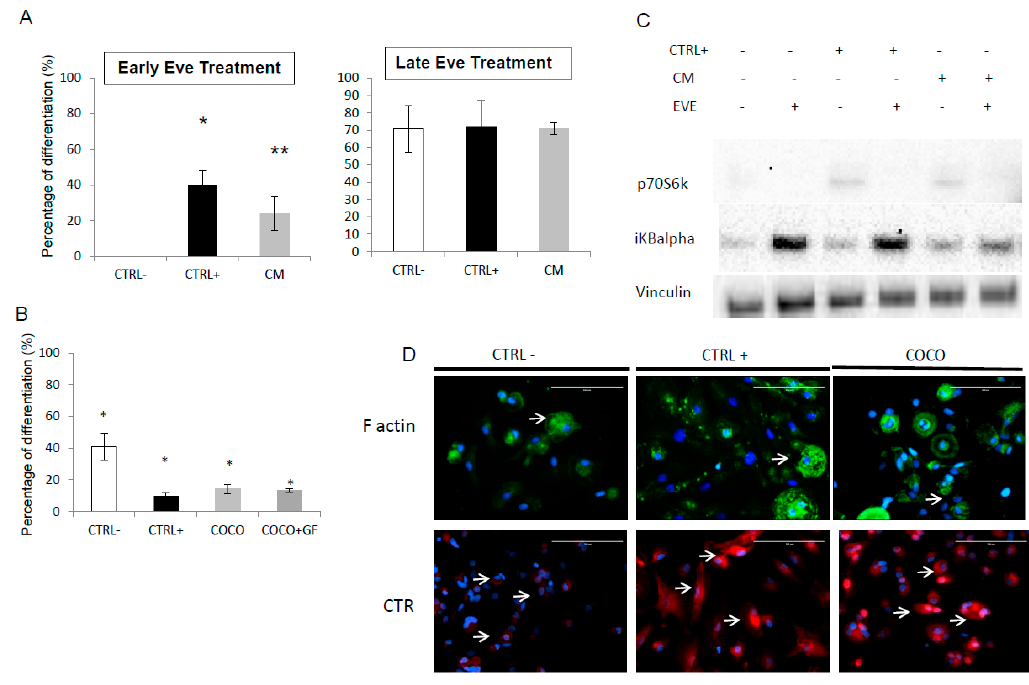
Figure 3. Everolimus effect on osteoclastogenesis treatment: Eve effect on osteoclastogenesis treatment: ( A ) INDIRECT COCO: percentage of differentiation with respect to untreated samples after administration on Day 3 of osteoclastogenesis assay (early) and on Day 10 (late). The experiment was performed as described for Figure 1. Significance: * p < 0.05; ** p < 0.01 Eve was used at a concentration of 0.1 µg/mL; ( B ) DIRECT COCO: percentage of differentiation after treatment with Eve with respect to untreated samples. The significance is related to the TRAP + polykarions number change in treated vs. untreated samples in the same conditions. Significance: * p < 0.01; ( C ) Western blot analysis on osteoclasts treated with Eve for 6 h and conditioned with SCP2 CM or frowth factors (CTRL+) IKBalpha and p70S6K were evaluated. The latter protein was expressed only in presence of GF or CM and was downregolated after Eve administration; ( D ) Phalloidin and CTR staining to detect F actin ring and CTR expression on osteoclasts in all different conditions treated with Eve. The scale bar is 100 µm.